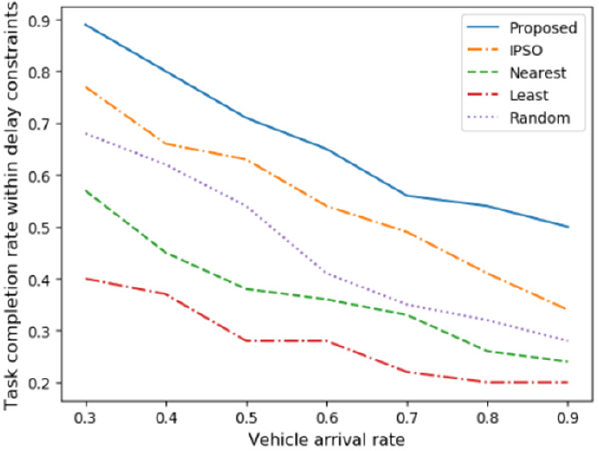
Figure 11. System throughput for vehicle arrival rate.